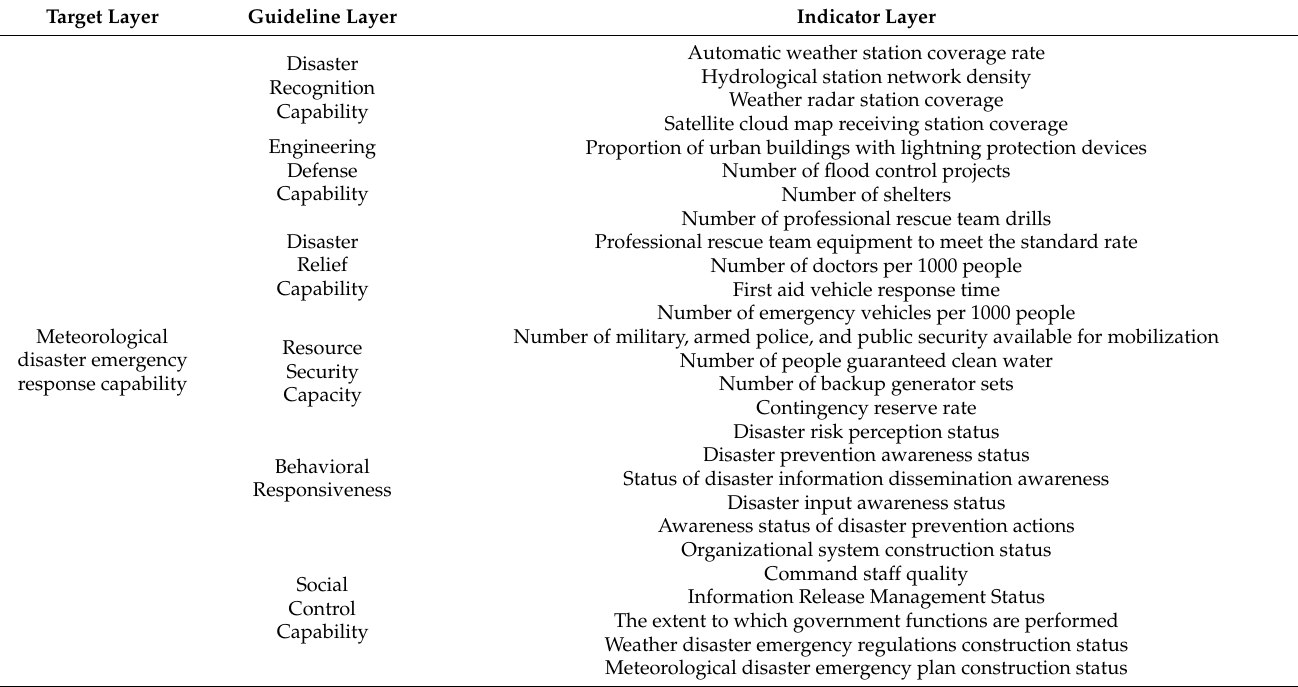
Table 1. Evaluation index system of meteorological disaster emergency capability.